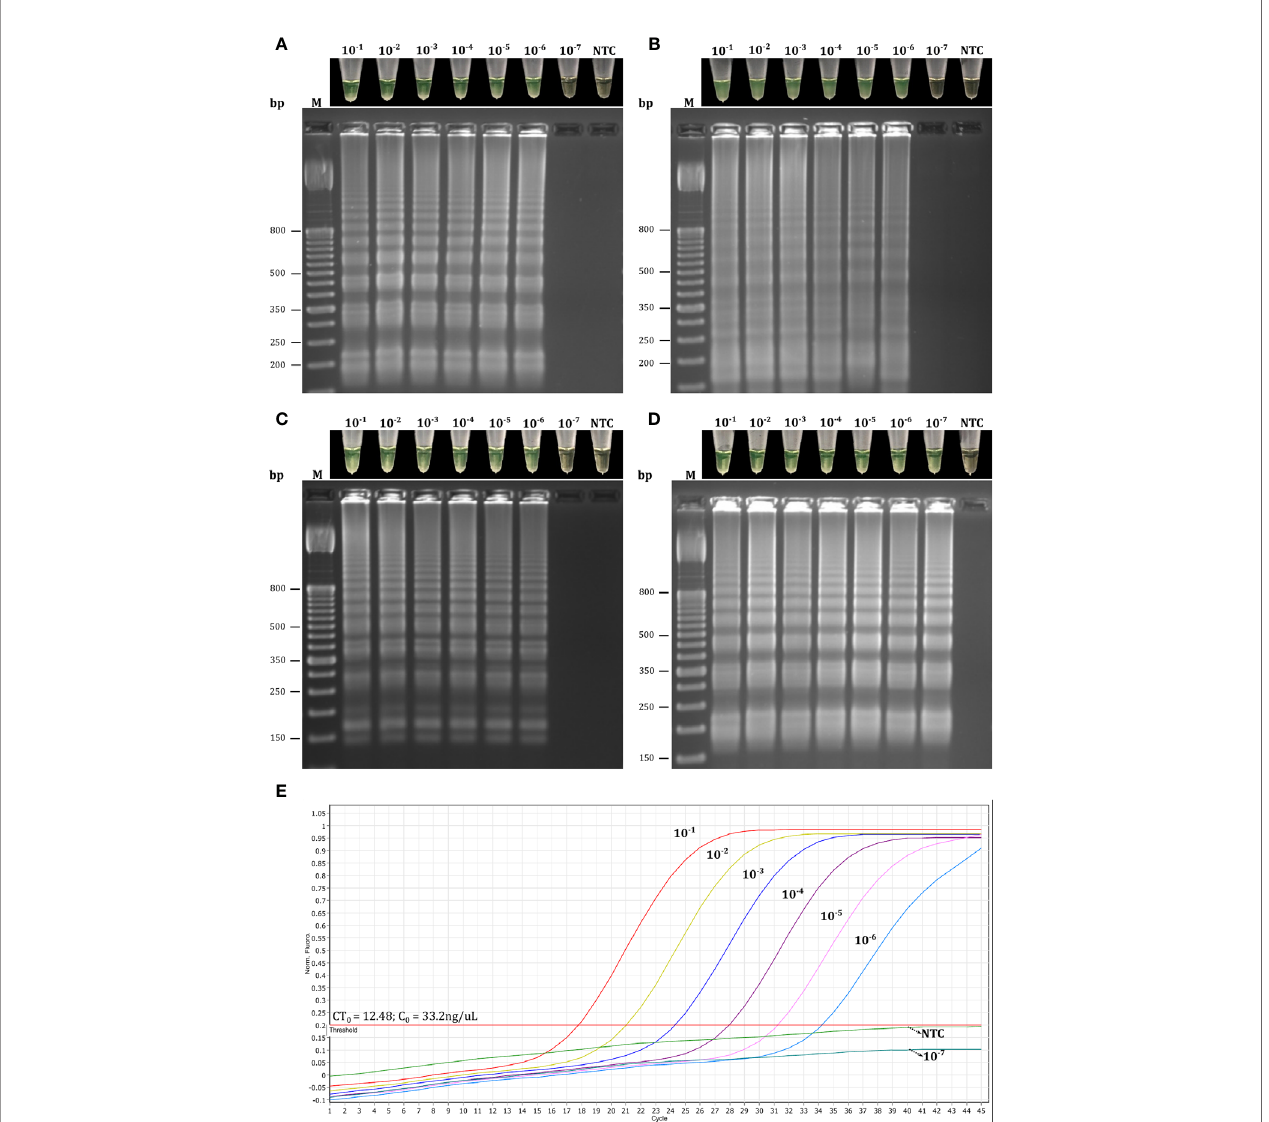
FIGURE 7 | Evaluation of the single LAMP primer sets based on target dilution. Reactions using primer sets R18 (A) , 8N3 (B) , R2 (C) , and R34 (D) were considered positive for RT-LAMP products if they had both a color change from brown to green and a laddered banding pattern on agarose gel after electrophoresis. Target dilution was based on log10 dilutions (10 -1 to 10 -7 ) of SARS-CoV-2 RNA obtained from clinical samples and the samples were analyzed in parallel by simplex RT- LAMP (A – D) and RT-qPCR (E) assays. CT 0 , initial cycle threshold value of the clinical samples obtained by RT-qPCR; C 0 , initial concentration of the clinical samples; NTC, negative non-template control; bp, base